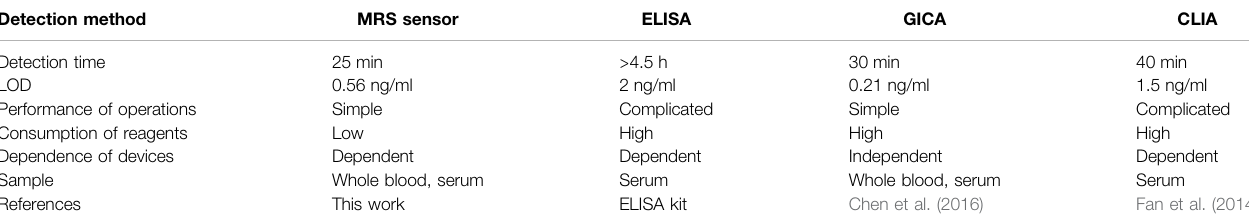
TABLE 1 | The characteristics of the MRS sensor are compared with those of the MRS sensor in other methods. Detection